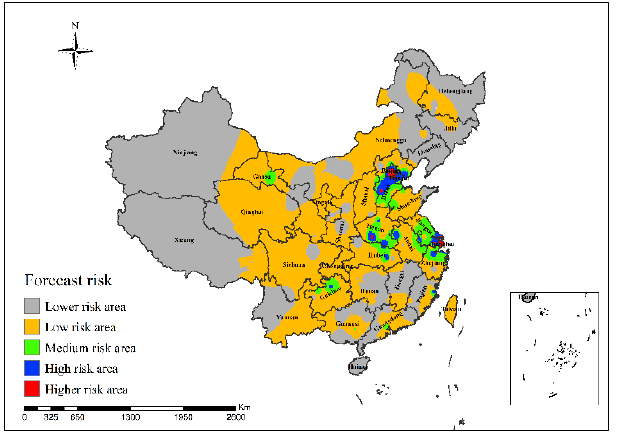
Figure 13. Risk simulation results of H7N9 outbreaks in China in 2013.